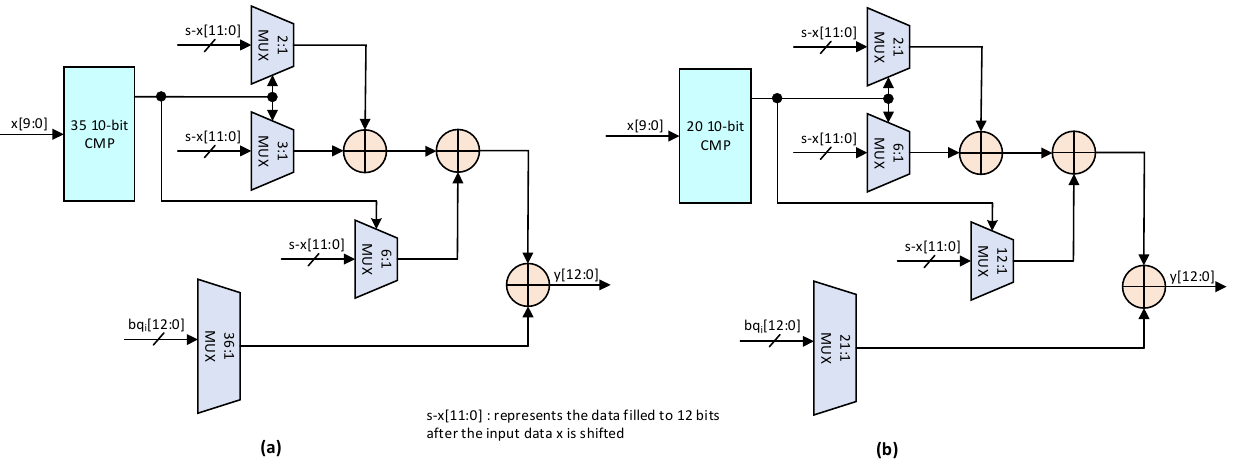
Figure 8. The hardware architectures in ML-PLAC ( a ) and OML-PLAC; ( b ) of the third sets of experiments in Table 6.